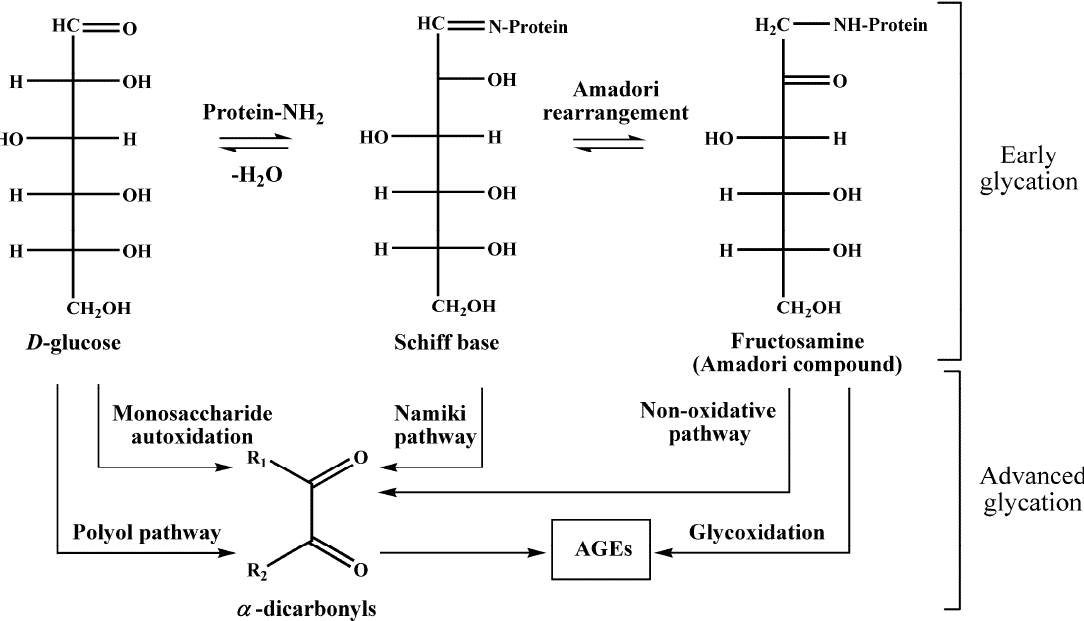
Figure 1. Early and advanced glycation in human blood plasma. The major pathways of advanced glycation end product (AGE) formation: monosaccharide autoxidation (Wolff-pathway), autoxidation of aldimins (Namiki-pathway), polyol pathway, autoxidation of Amadori products (Hodge-pathway), and non-oxidative pathway.